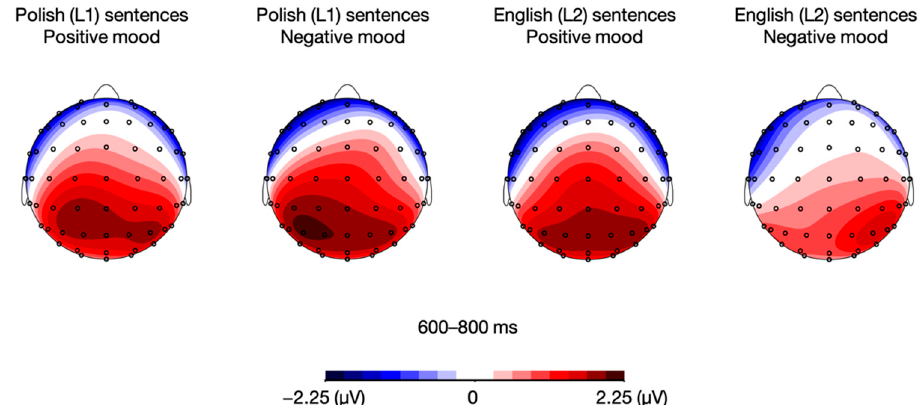
Figure 10. Topographic distribution of the difference between ERP amplitudes in the meaningful and meaningless conditions for Polish (L1) and English (L2) sentences in the positive and negative mood conditions in the 600–800 ms time window.